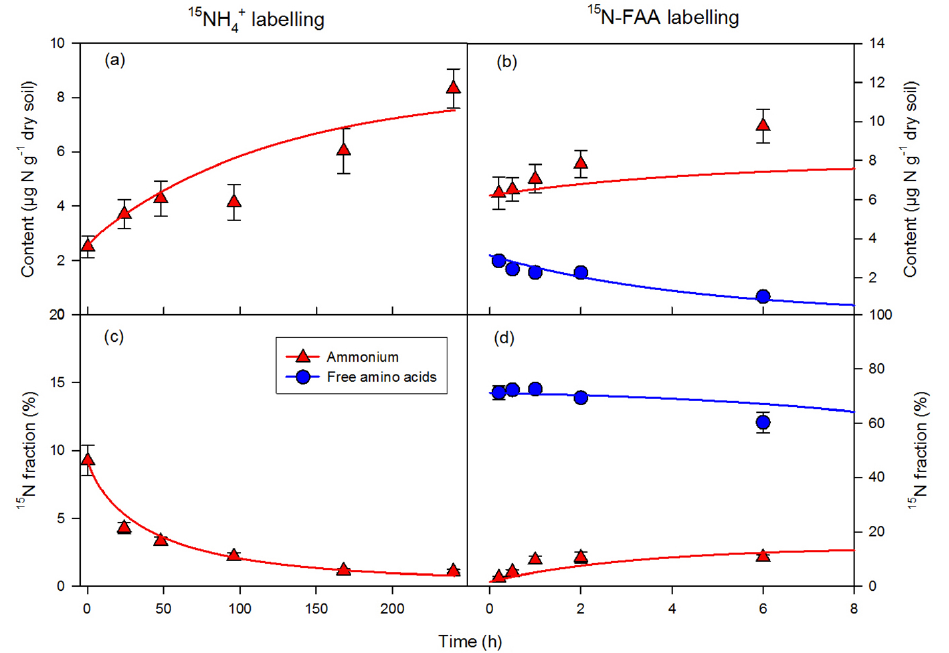
+ labelling and 15 N–FAA labelling; symbols indicate data observation 4